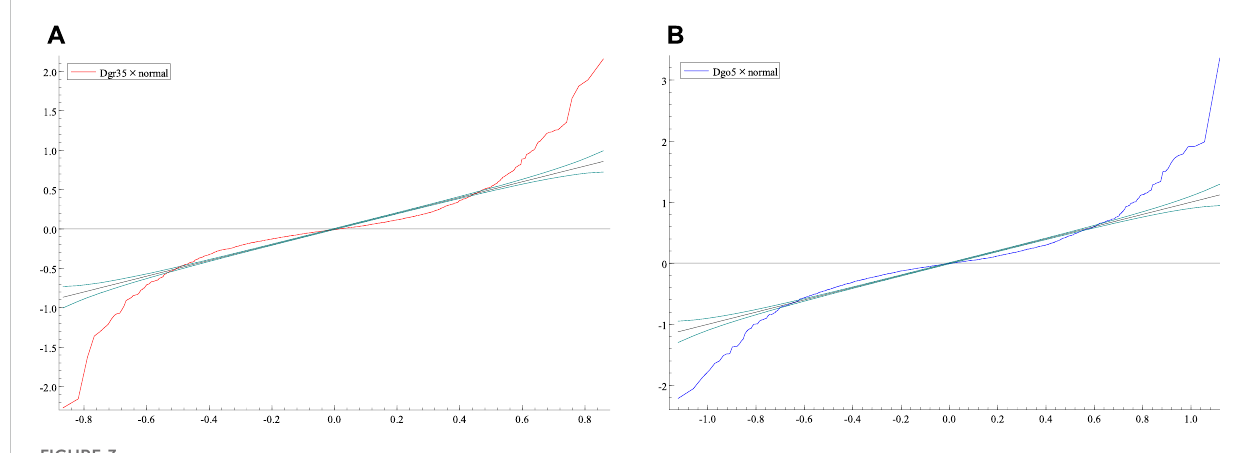
FIGURE 3 Comparison of the distributions of Dgr35 and Dgo5 with the normal distribution.